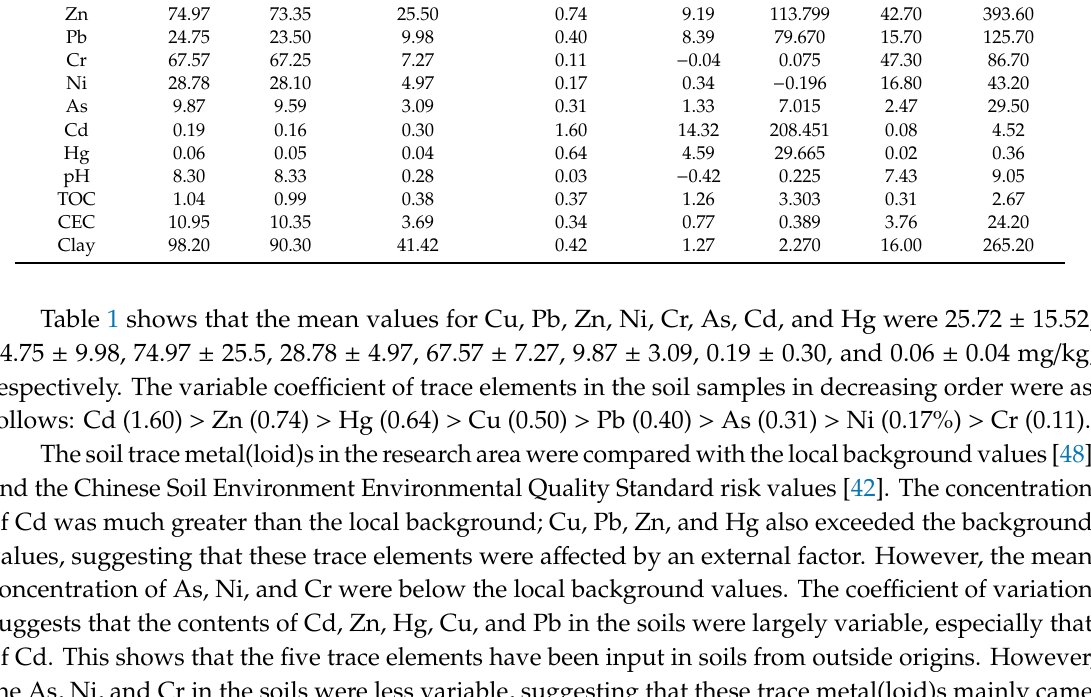
Table 2. Descriptive statistics of trace metal(loid)s and physicochemical property parameters in the soil in the study area (unit: mg / kg, expect for K, Ca, Mg, Fe, and Mn were %). Std. Deviation Coe ffi cient of Skewness Kurtosis Minimum Maximum Parameters Mean Median (SD) Variable (CV) Cu